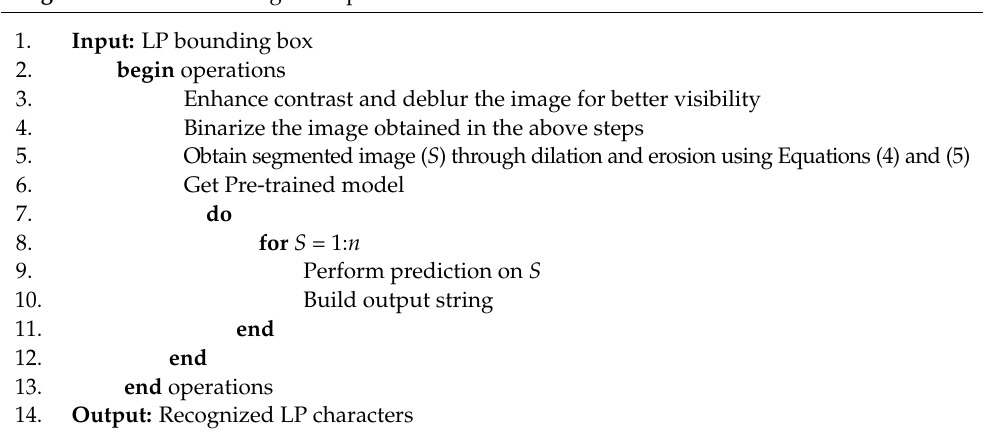
Algorithm 3: The LP recognition